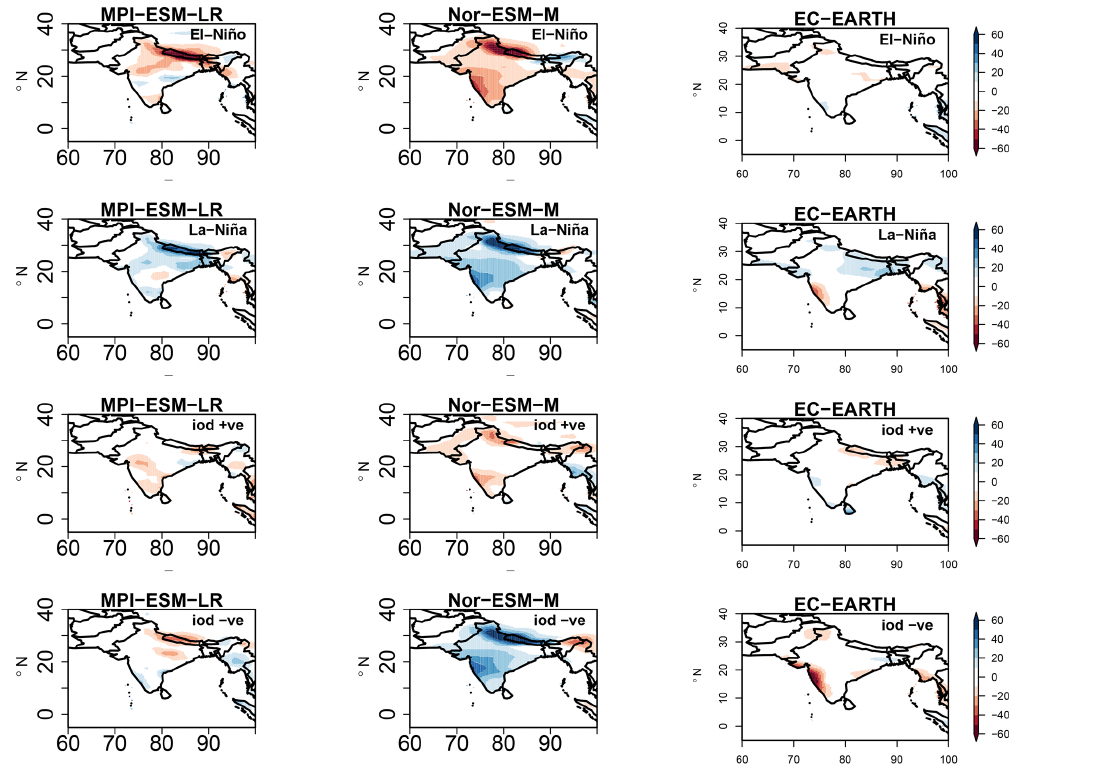
Figure 8. Total precipitation anomaly composites over the Indian subcontinent (JJAS) for El Niño, La Niña, and positive IOD and negative IOD events in MPI-ESM-LR, Nor-ESM, and EC-EARTH simulations